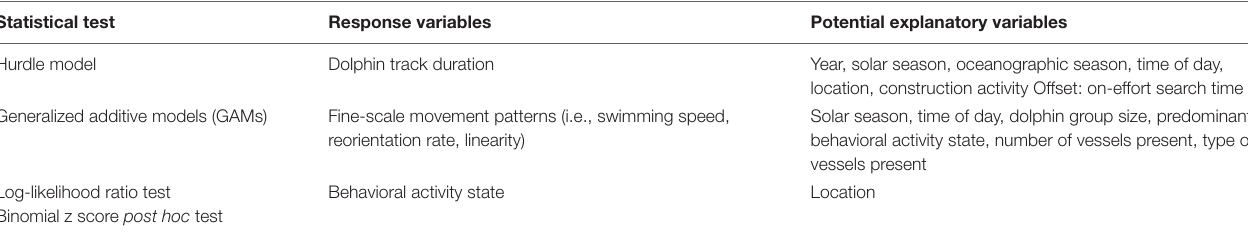
Table includes all potential explanatory